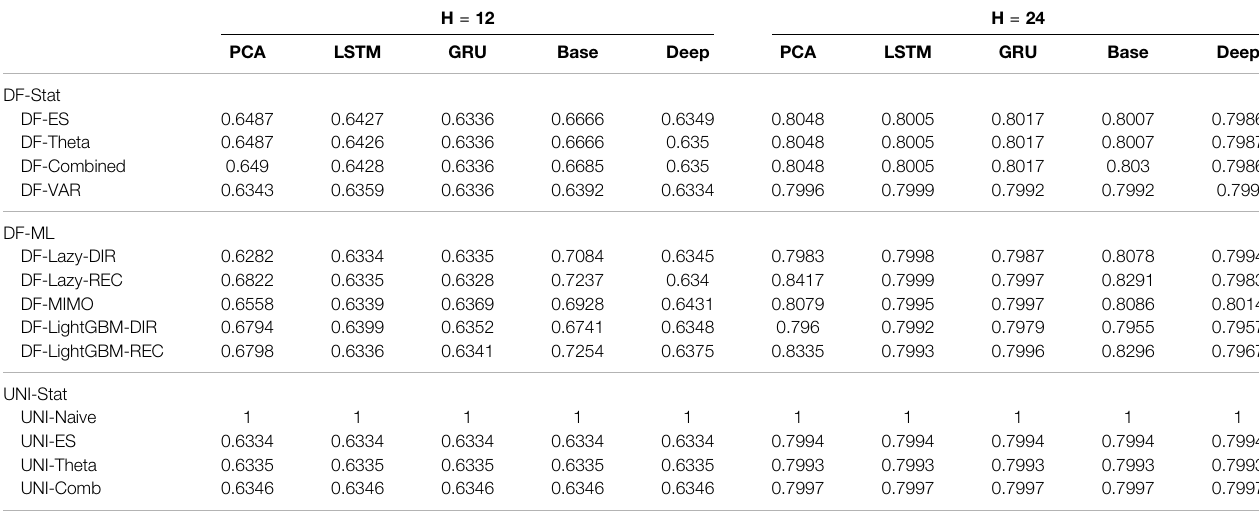
TABLE 3 | Mobility Naive Normalized MSE for H ∈ {12, 24}. The content of the cell c ij represents the model using the j th dimensionality reduction technique with the i th forecasting method. The NNMSE for the Naive method is equal to 1. An NNMSE < 1 indicates that the proposed method outperforms the Naive method.